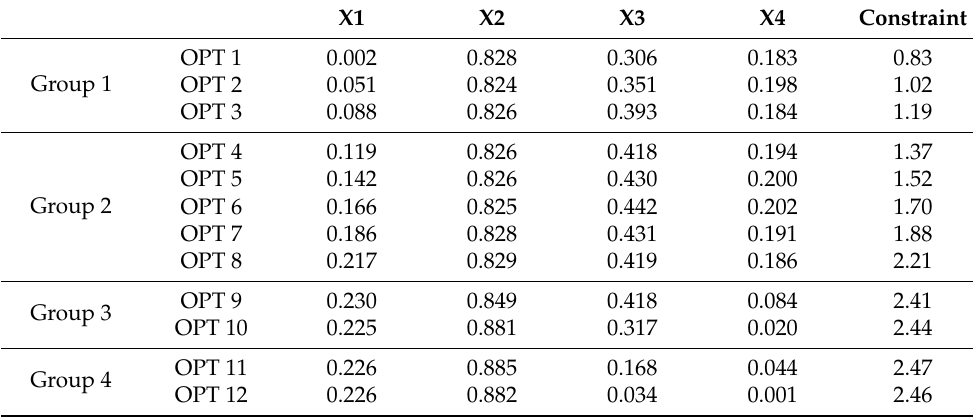
Table 3. Design variables and geometric constraint for representative optimal